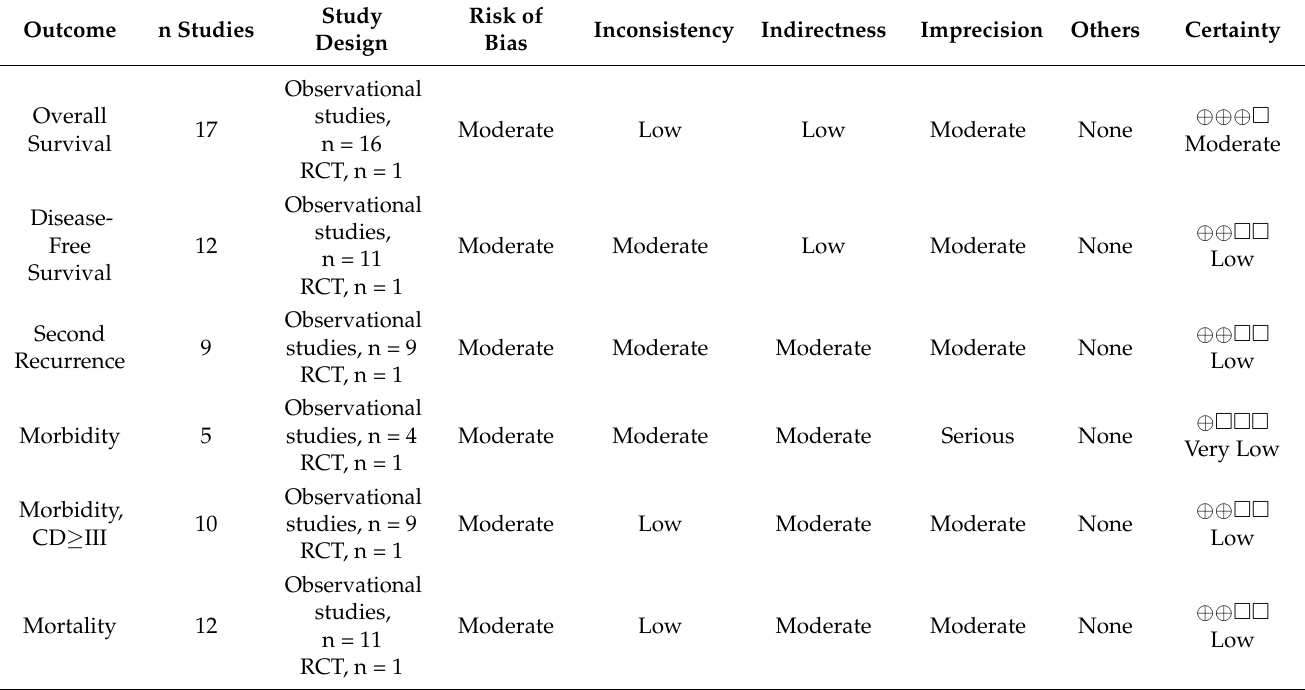
Table 4. Results of Quality Assessment of Studies Included in Meta-Analyses (The Grading of Recommendations Assessment, Development and